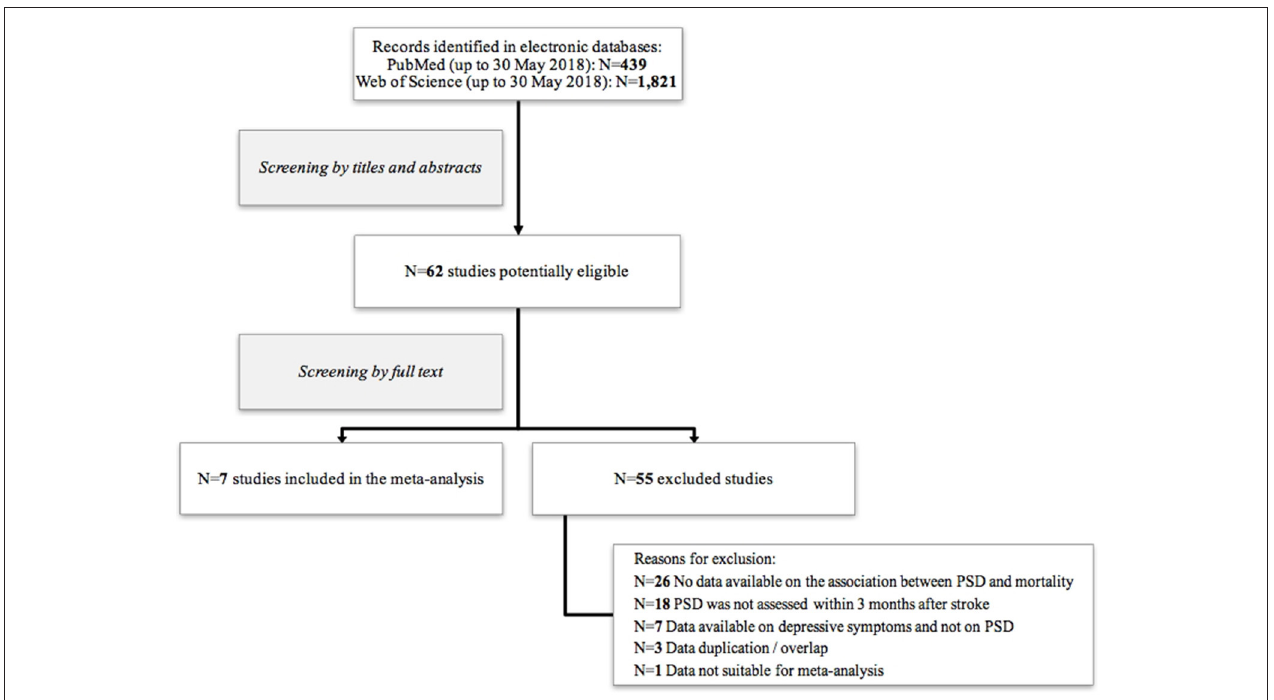
FIGURE 1 | Flow chart of included/excluded